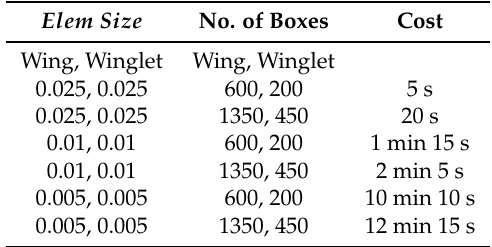
Table 6. Computational cost for wing with winglet beam